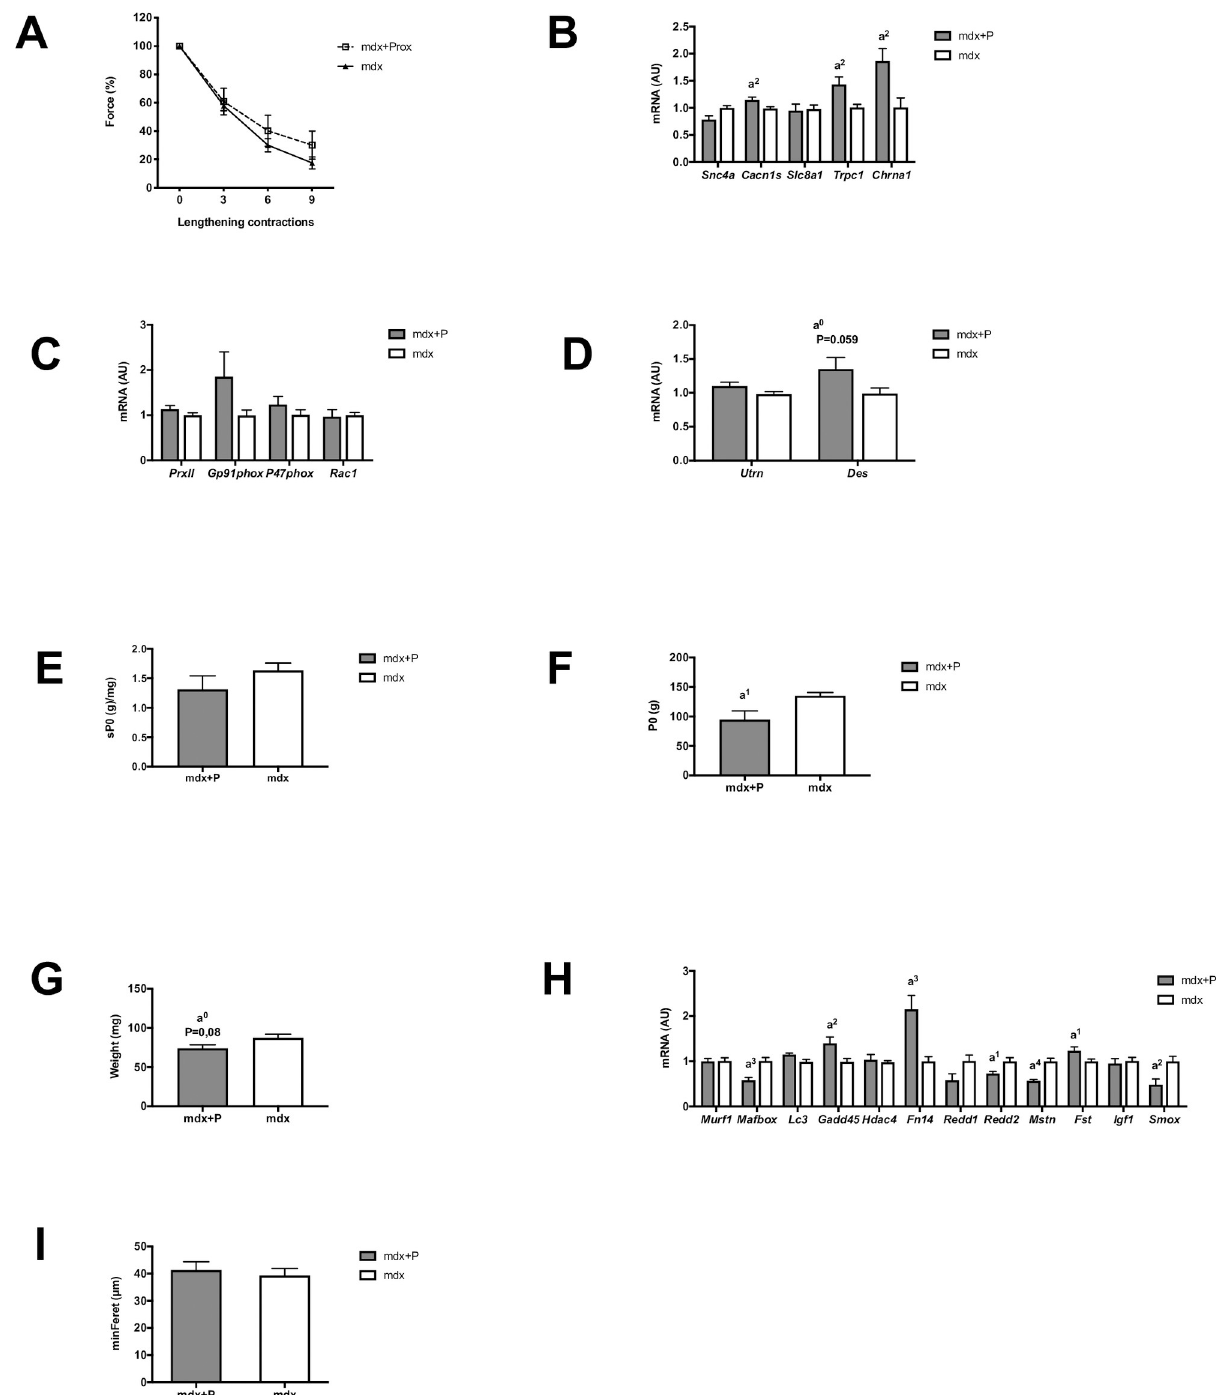
Fig 6. Effect of Prox1 transfer on fragility (susceptibility to contraction induced muscle damage) and related gene expression, absolute (P0) and specific (sP0) maximal forces, muscle weight and gene expression of atrophy markers in voluntary exercised mdx mice (first set of experiment) in sedentary mdx mice (second set of experiment). (A) Force drop following lengthening contractions in Mdx+P and Mdx muscle. n = 5–8 per group. (B) Expression of genes encoding ion channels, related to excitability in Mdx+P and Mdx muscle. N = 6–11 per group. (C) Expression of genes, related to NADPH oxidase 2 (NOX2) in Mdx+P and Mdx muscle. N = 6–11 per group. (D) Expression of genes encoding utrophin ( Utrn ) and desmin ( Des ) in Mdx+P and Mdx muscle. N = 6–11 per group. (E) Specific maximal force in Mdx+P and Mdx muscle. n = 5–8 per group. (F) Absolute maximal force in Mdx+P and Mdx muscle. n = 5–8 per group. (G) Muscle weight in Mdx+P and Mdx muscle. n = 5–9 per group. (H) Expression of genes related to